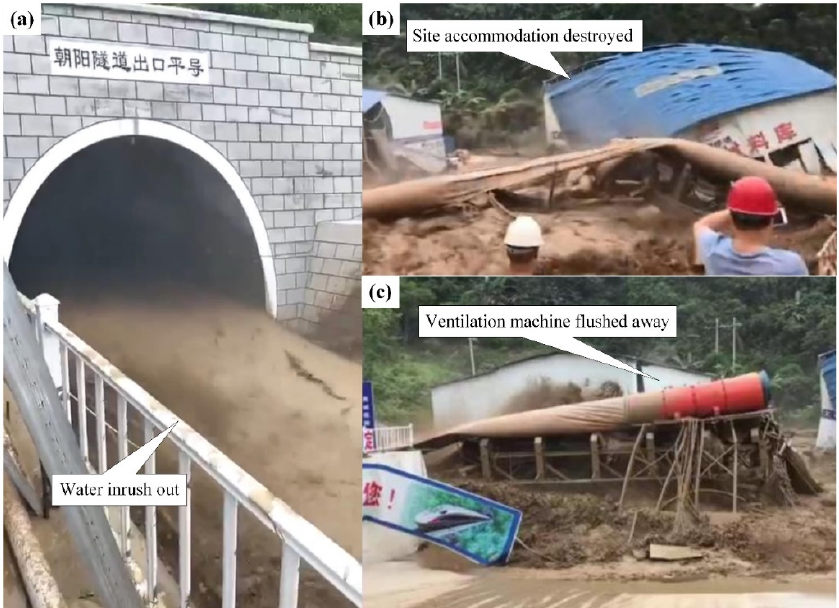
Figure 3. Accident scenes: ( a ) Water rushing out of structural opening; ( b ) portable dwellings destroyed by inrushing water; and ( c ) ventilation machine flushed away by inrush water.